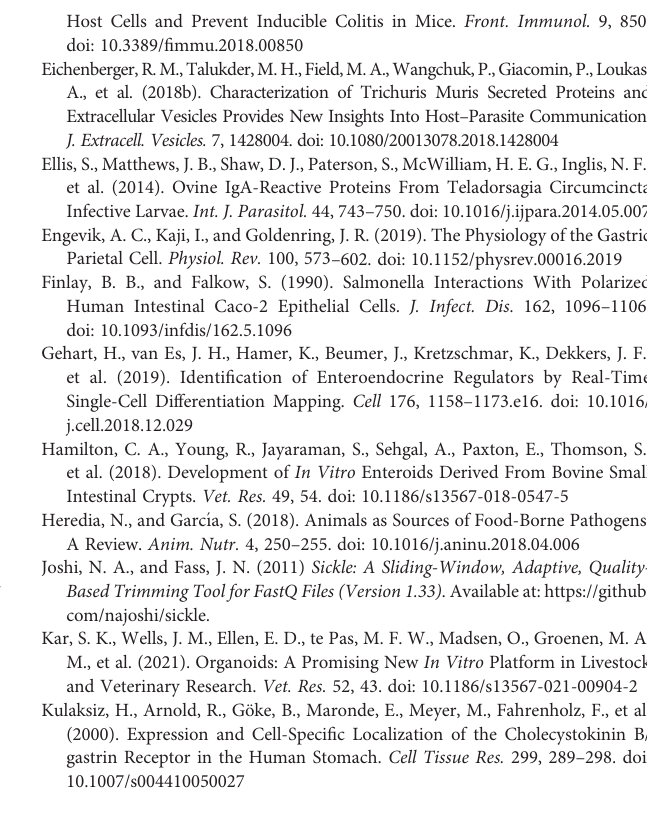
Supplementary Figure 1 | Negative controls for immuno fl uorescence antibody labelling in abomasum organoids. Representative confocal microscopy images of abomasum organoids probed with non-speci fi c host IgG followed by indirect Alexa Fluor ® 488-conjugated secondary antibody labelling. Marker name in green brackets indicates the antibody labelling control each organoid image represents. Scale bars = 10 µm. Supplementary Figure 2 | Negative controls for immuno fl uorescence antibody labelling in intestinal organoids. Representative confocal microscopy images of ileumorganoids probed with non-speci fi chostIgG followed byindirect Alexa Fluor ® 488-conjugated secondary antibody labelling. Marker name in green brackets indicates the antibody labelling control each organoid image represents. Hoescht, blue. Scale bars = 10 µm. Supplementary Figure 3 | Heat map showing the expression of cell junction- related genes in abomasum and ileum tissue and organoids. RNA-seq analysis was performed to compare gene expression in abomasal and ileal tissue derived from fi ve lambs and abomasum and ileum organoids across multiple passages. Squares from left to right under “ abomasum tissue ” and “ ileum tissue ” represent lambs T1- T5. Squares from left to right under abomasum organoids and ileum organoids represent passages P0-P4. Scale = log 2 transcripts per million reads. Details of genes included in the heat map, including ENSOART sequence identi fi ers, are shown in Supplemental File 2 . Supplementary Figure 4 | Heat map showing the detection of immune-related gene expression in abomasum and ileum tissue and organoids. RNA-seq analysis wasperformedtocomparegeneexpressioninabomasalandilealtissuederivedfrom fi ve lambs and abomasum and ileum organoids across multiple passages. Squares fromleft toright under “ abomasumtissue ” and “ ileum tissue ” represent lambs T1-T5. Squaresfromlefttorightunderabomasumorganoids and ileum organoids represent passages P0-P4. Scale = log 2 transcripts per million reads. TLRs, toll-like receptors; CLRs, C-type lectin receptors. Details of genes included in the heat map, including ENSOART sequence identi fi ers, are shown in Supplemental File 2